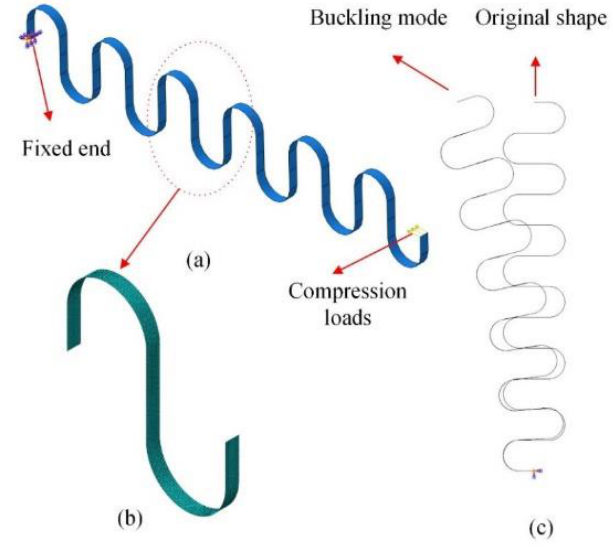
Figure 2. ( a ) FEM model, ( b ) meshes in one corrugation unit, ( c ) first-order buckling mode.